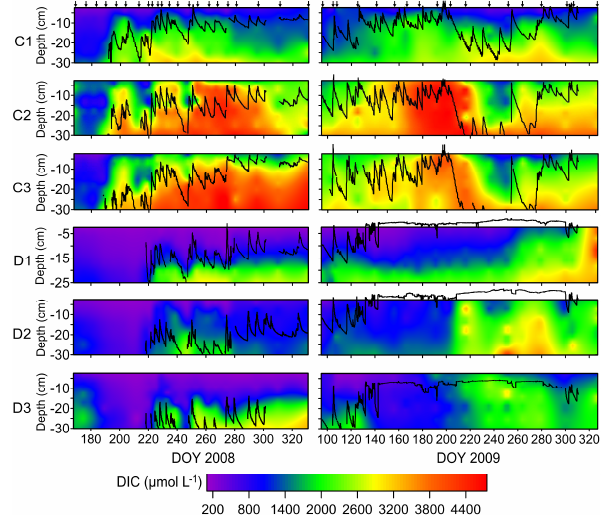
Fig. 3. Dissolved inorganic carbon (DIC) concentrations. Refer to caption in Fig. 2 (Estop-Aragon´es et al., 2012). Copyright 2012 American Geophysical Union. Reproduced by permission of Amer- ican Geophysical